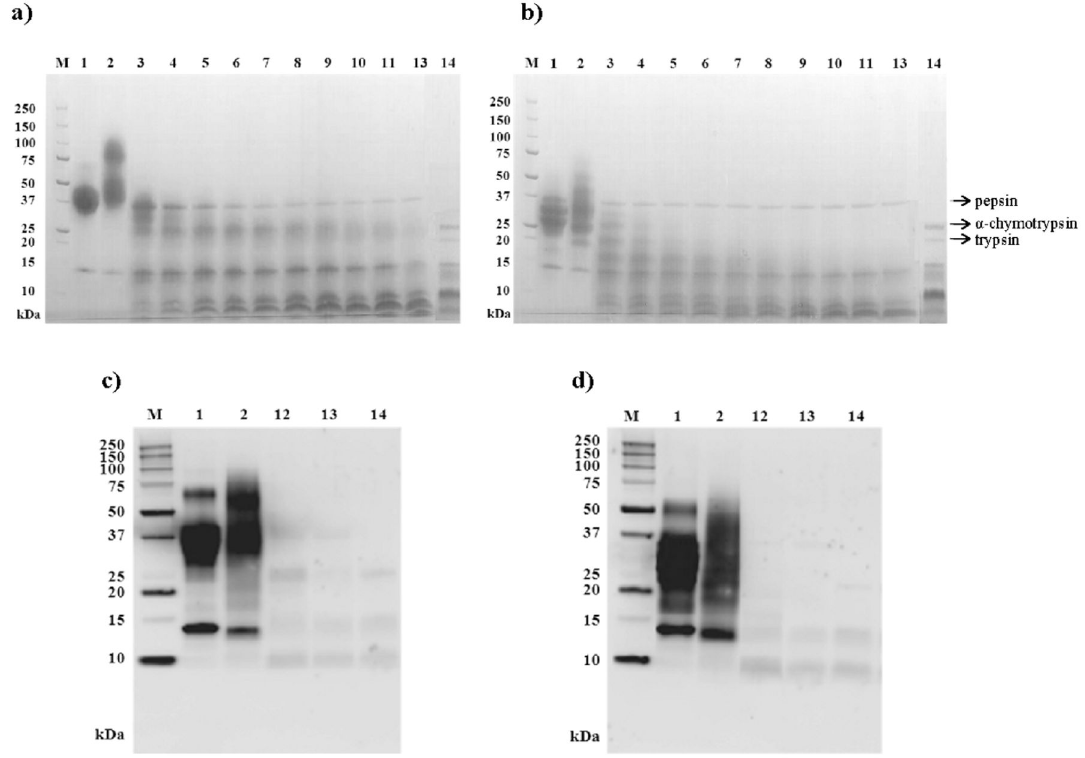
Figure 4. Orogastrointestinal digestions profile and immunoreactivity. SDS-PAGE patterns (a, b) and Western blotting (c, d) of OM (a, c) and dOM (b, d) after in vitro oral, gastric and gastroduodenal digestions. M: molecular mass marker; 1: OM (a, c) and dOM (b, d); 2: oral digest; 3-13: gastric digests at 1, 2, 3, 4, 5, 7, 10, 15, 20, 30 and 60-min; 14: duodenal digests (60 min of gastric digestion followed by 30 min of duodenal digestion). Membranes were incubated with a pool of sera (patients 1, 3, 5, 7 and 9, Table